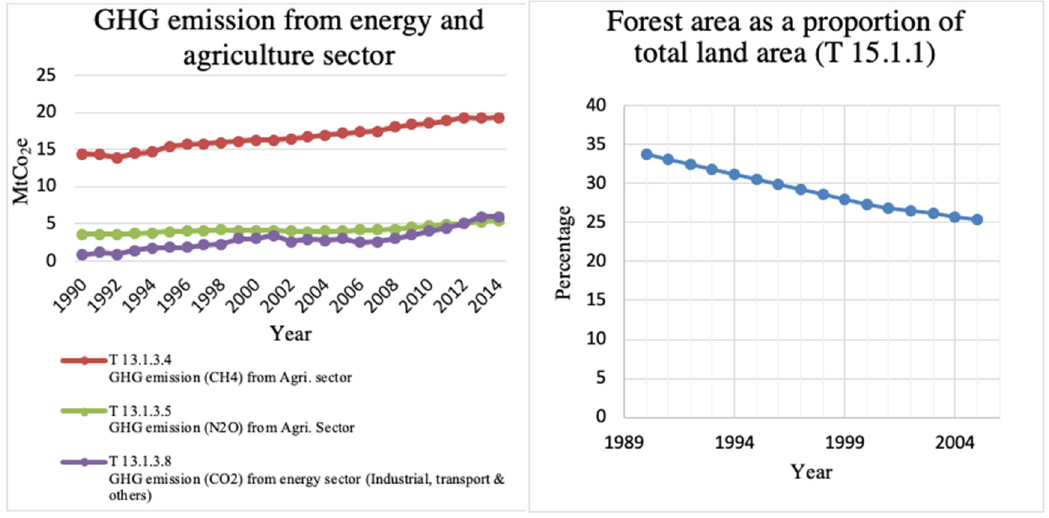
Figure 17. GHG emission from energy and agriculture sector ( left ) and forest area as a proportion of total land area (% change) ( right ).